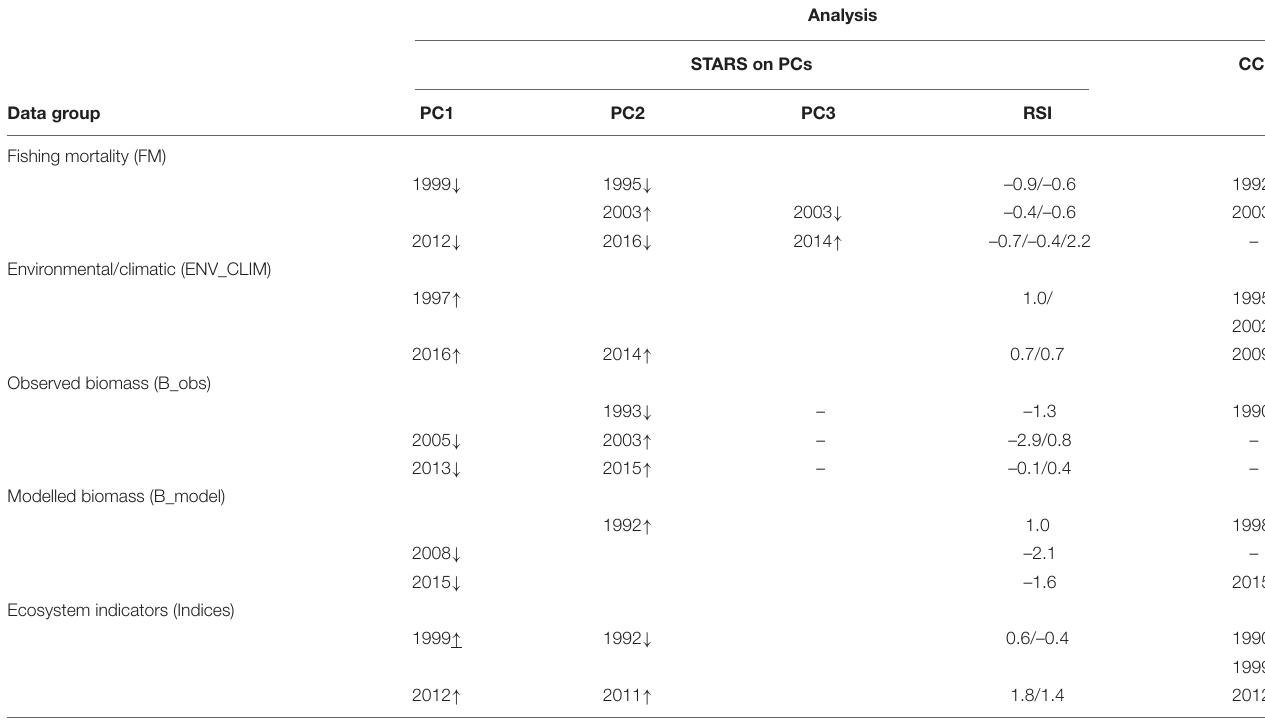
TABLE 6 | Results of the sequential t -test analysis of regime shift (STARS) on principal component analysis (PCA) output and chronological clustering (CC)